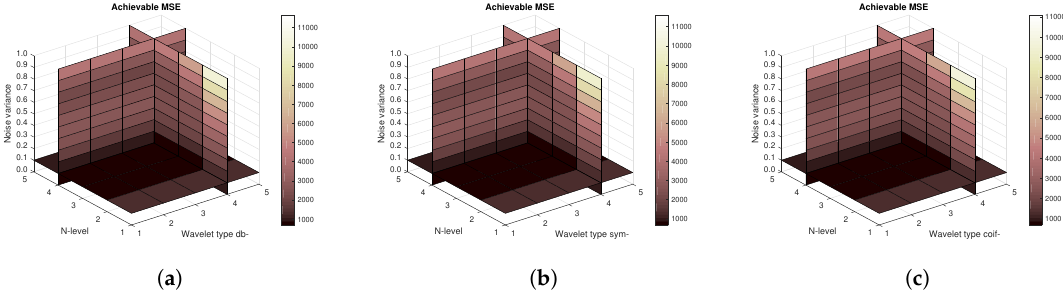
Figure 12. Mean achievable MSE values for 60 MRI images with use of three mother wavelet families—from left Daubechies ( a ), Symlet ( b ) and Coiflet ( c ).